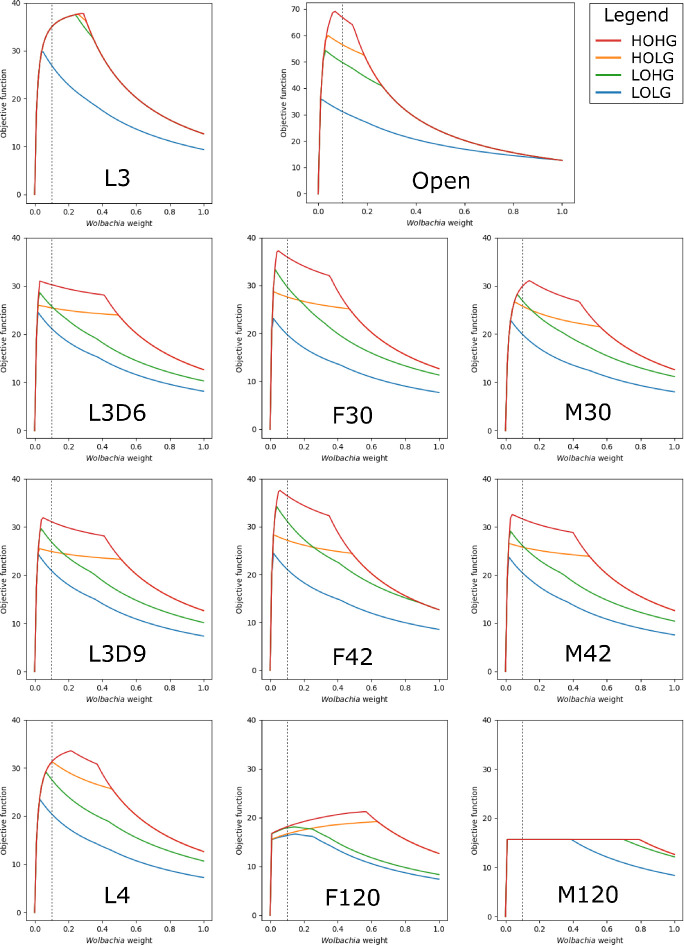
The effect of the Wolbachia weight on the maximum objective function flux when supplemented with excess pyruvate.The life stage models were generated by mapping different stage-specific expression data on the unconstrained (Open) model: larval stage 3 (L3), L3 6 days post-infection (L3D6), L3 9 days post-infection (L3D9), L4, adult female 30 days post-infection (F30), adult female 42 days post-infection (F42), adult female 120 days post-infection (F120), adult male 30 days post-infection (M30), adult male 42 days post-infection (M42), and adult male 120 days post-infection (M120). As compared to Figure 2, the models here were provided with excess pyruvate.